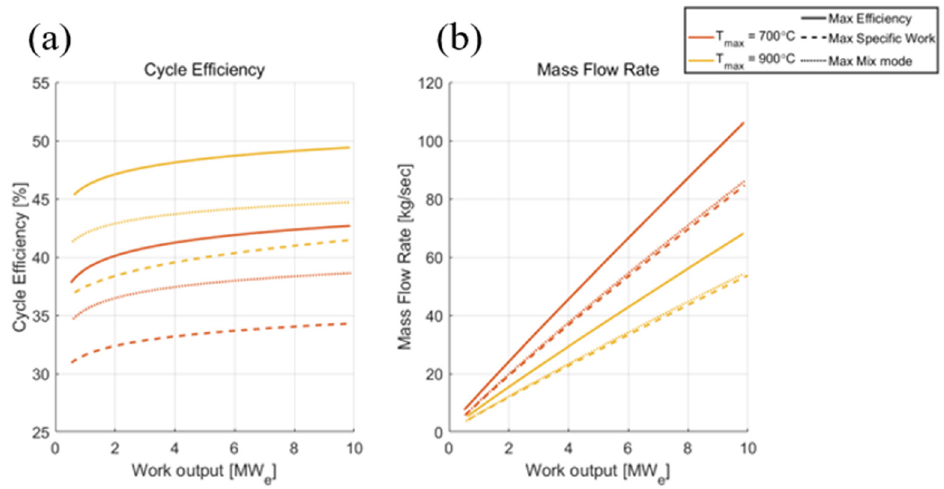
Figure 17. ( a ) Cycle efficiency and ( b ) cycle mass flow rate of open-air Brayton Cycle.